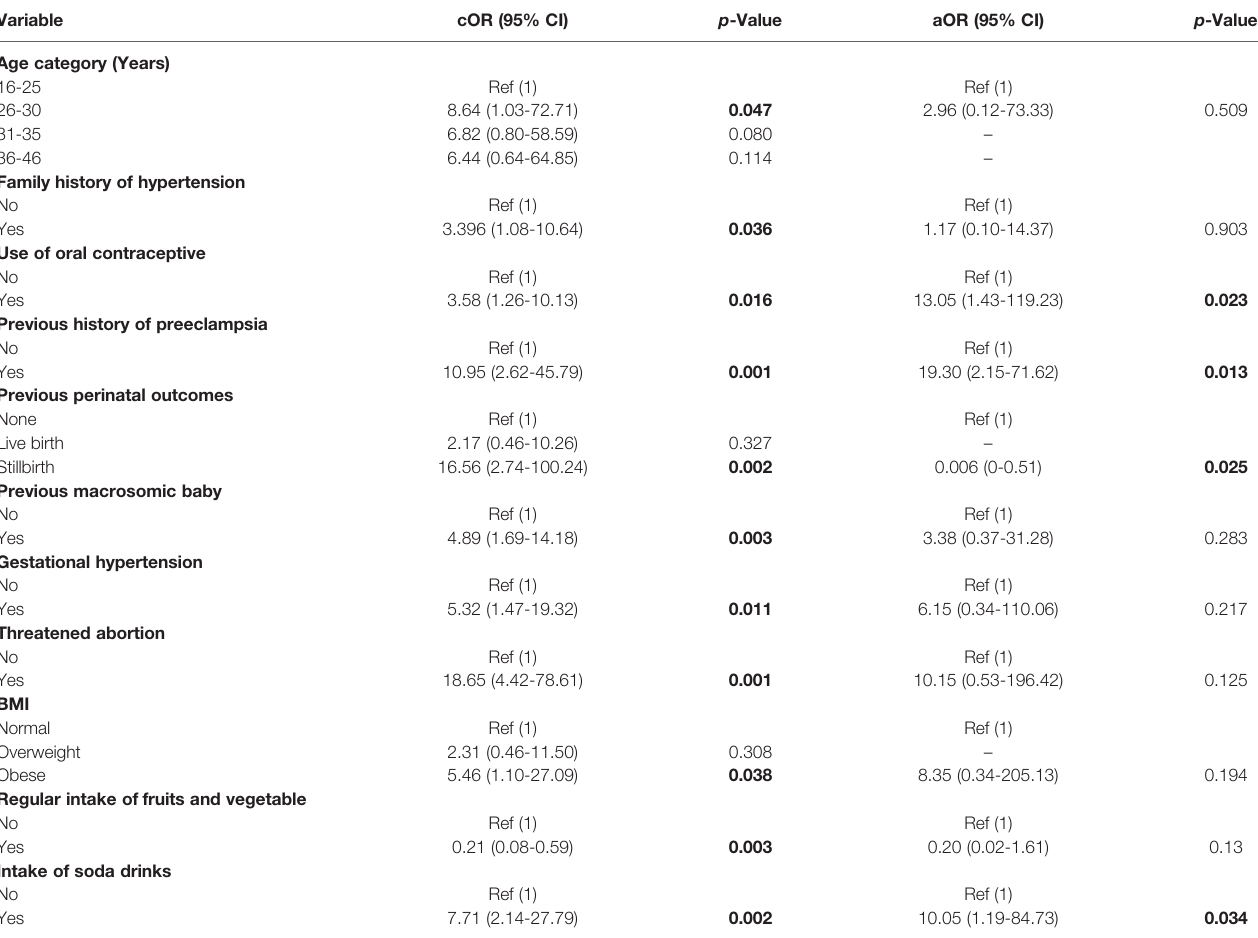
TABLE 3 | Risk factors associated with gestational diabetes.